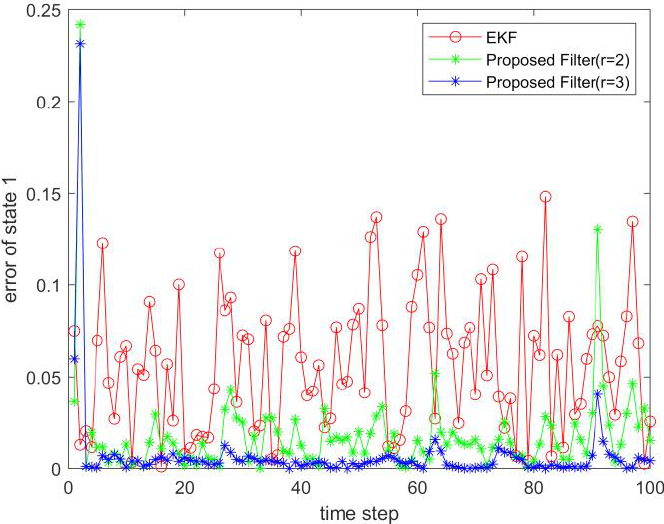
Figure 11. Estimation error of state 1.